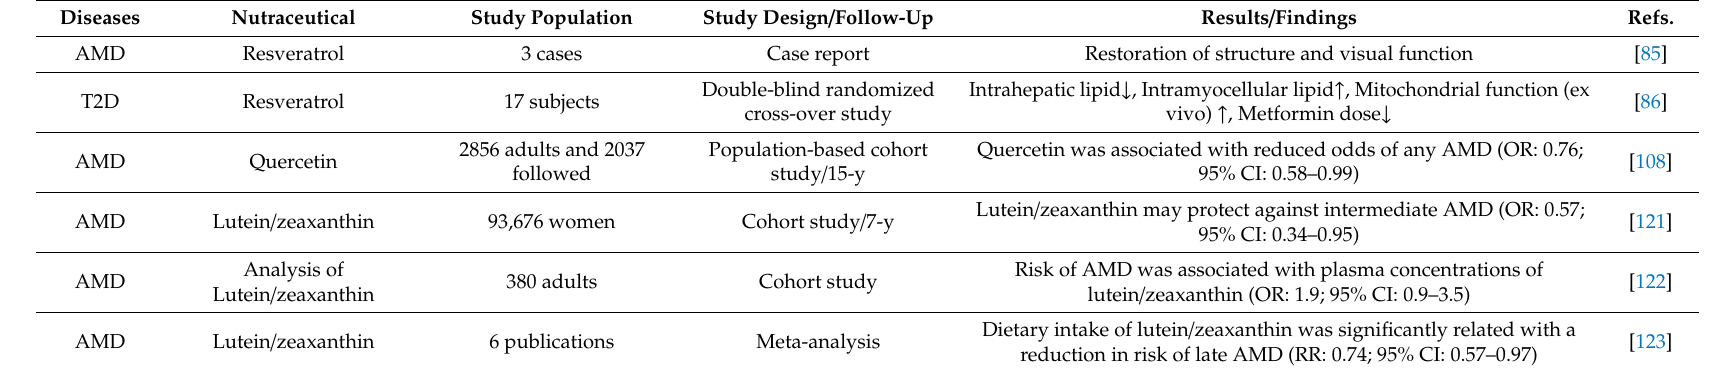
Table 2. Main significant outcomes of nutraceuticals in clinical